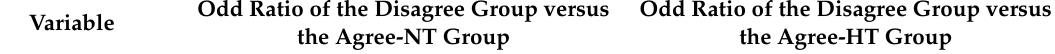
Table 4. Determinants of the diagnostic disagreement between home and ambulatory measurements, as determined by the logistic regression analysis.